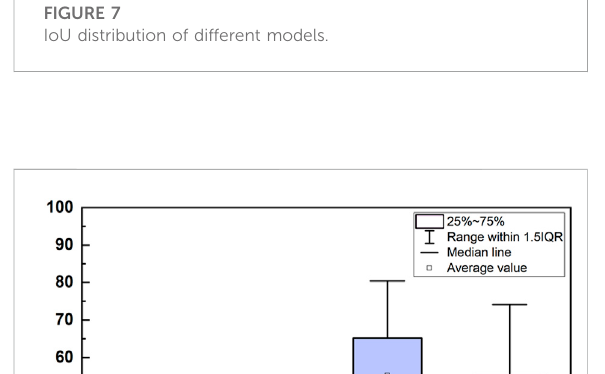
FIGURE 7 IoU distribution of different models.